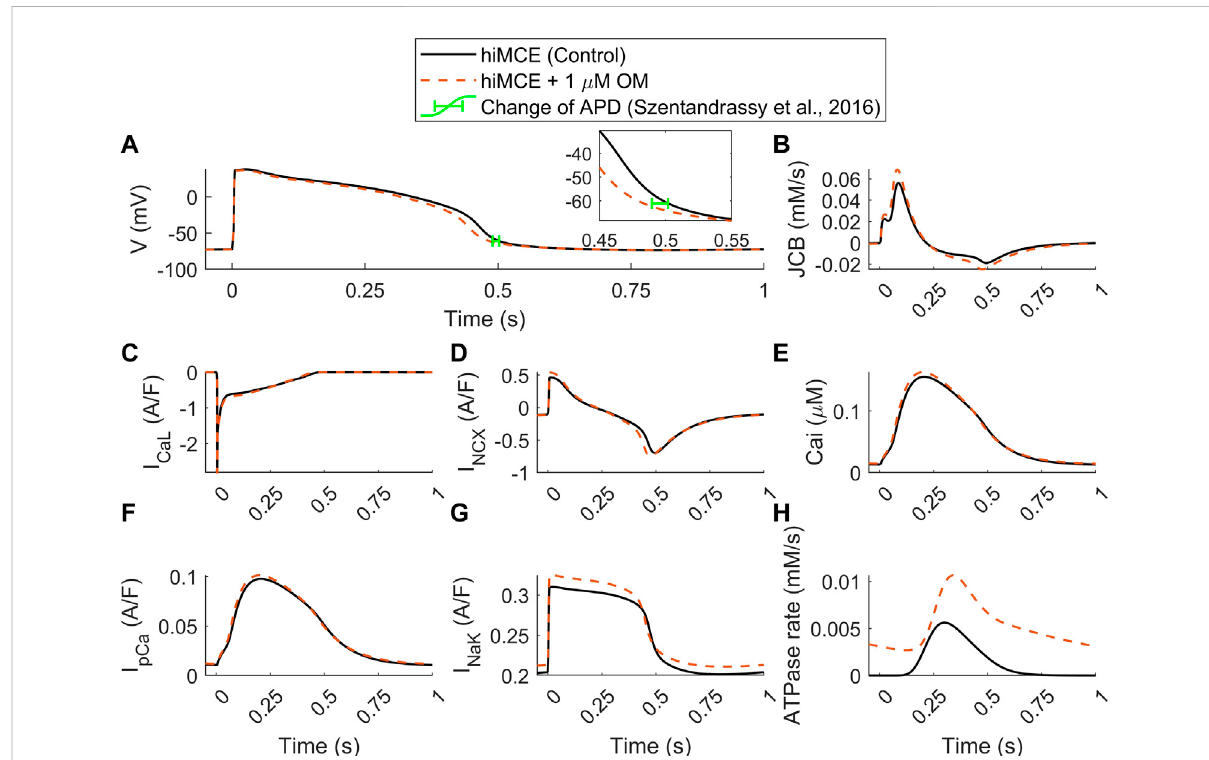
FIGURE 5 Predicted effect of 1 µM OM by hiMCE on action potentials (A) , Ca 2+ fl ux towards the myo fi lament (B) , L-type Ca 2+ current (C) , Na + /Ca 2+ exchanger I NCX (D) Ca 2+ transients (E) , sarcolemmal Ca 2+ pump current (F) , Na + /K + pump (G) , and ATPase rates (H) . The change of APD has been considered calculating